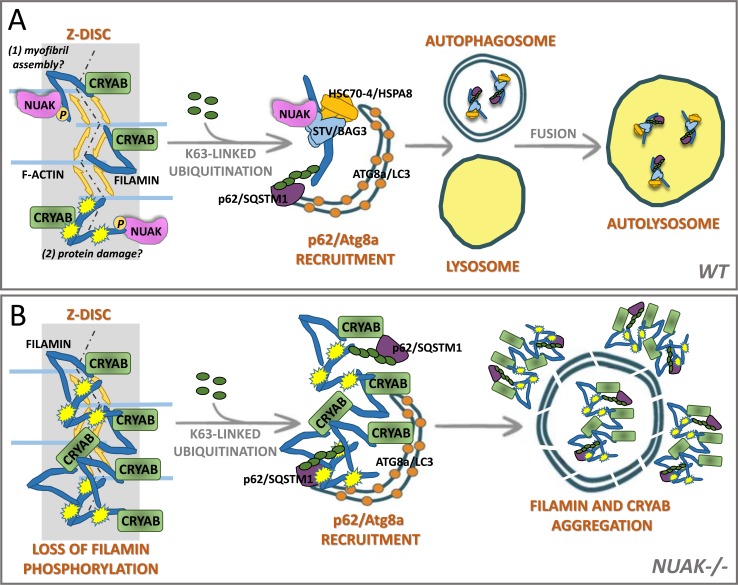
Model for NUAK function.(A) Autophagic protein clearance of Fil in WT muscle tissue. NUAK phosphorylates Fil either for incorporation into the Z-disc (1) and/or upon protein damage due to folding and unfolding of the protein (2). CryAB is normally bound to Fil at the Z-disc and the Stv-Hsc70-4 protein complex detects damaged Fil protein. The addition of K63-linked polyubiquitin chains on Fil recruits p62/SQSTM1 and Atg8a for autophagosome biogenesis. Autophagosomes fuse with lysosomes to form the autolyosome for eventual protein degradation. (B) Fil phosphorylation is lost in NUAK-/-. Unincorporated and/or damaged Fil protein at the Z-disc bound to CryAB. PolyUb, p62, and Atg8a proteins are still recruited to Fil-CryAB complexes. The absence of lysosomes in regions of protein accumulation prevents autophagic protein clearance.